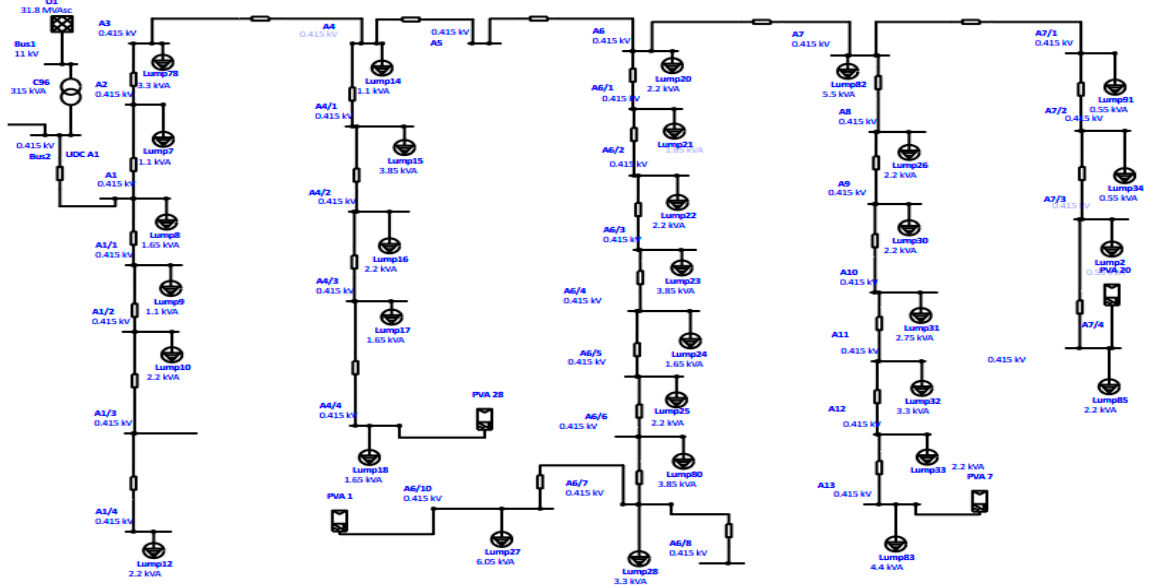
Figure 3. ETAP one-line diagram for a section of the PV-solar-integrated real urban ECG network.